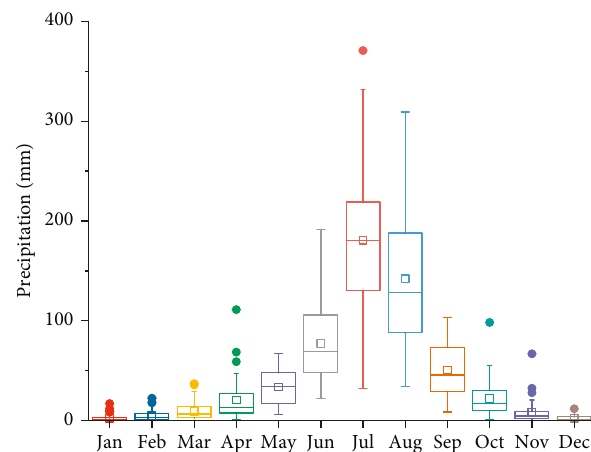
Figure 4: Box-plot for monthly precipitation amount during 1960–2012. The boxes indicate the 25th, 50th, and 75th percentiles and the whiskers indicate the values with maximum 1.5 interquartile ranges. The hollow square indicates the mean value. The solid circle means the